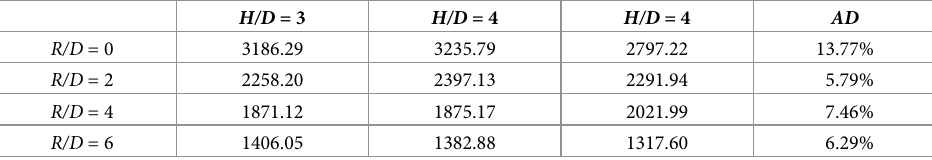
Table 3. Average convective heat transfer coefficient and AD at different heat transfer positions and nozzle-to- target